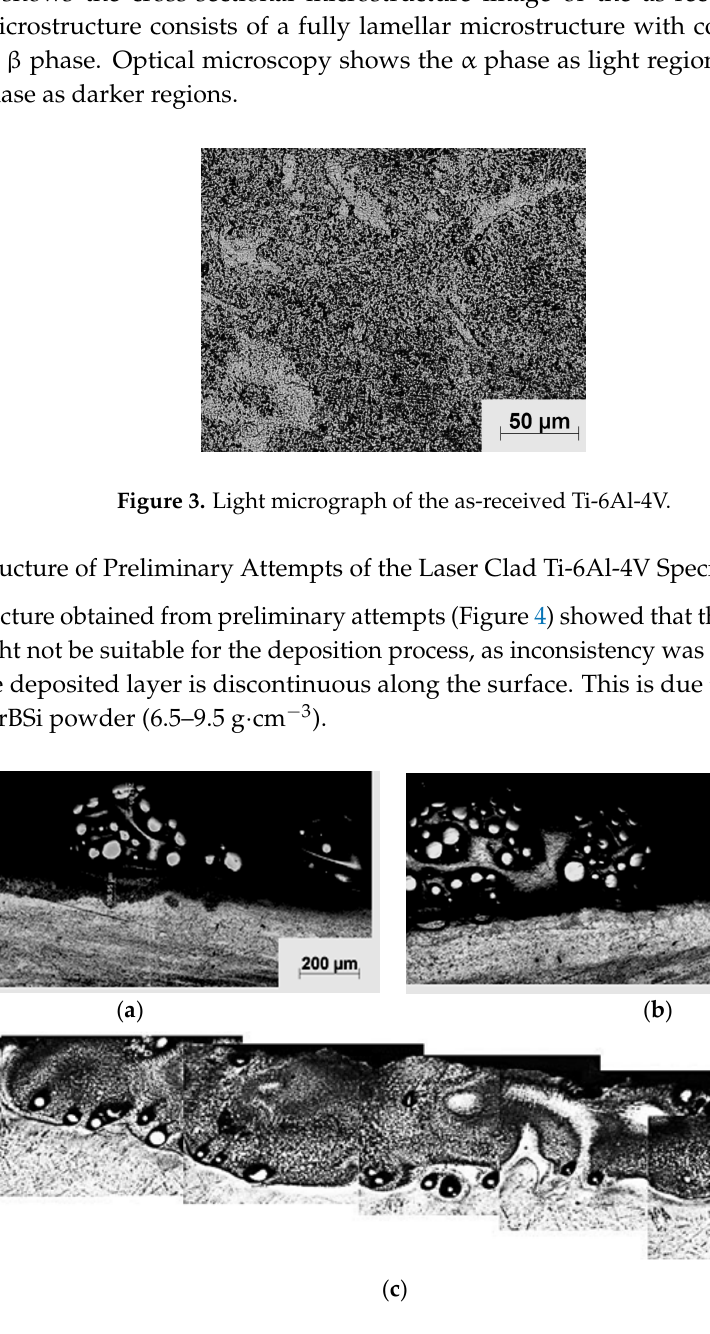
Figure 4. Light micrographs of the cross section of the laser clad samples processed at specific